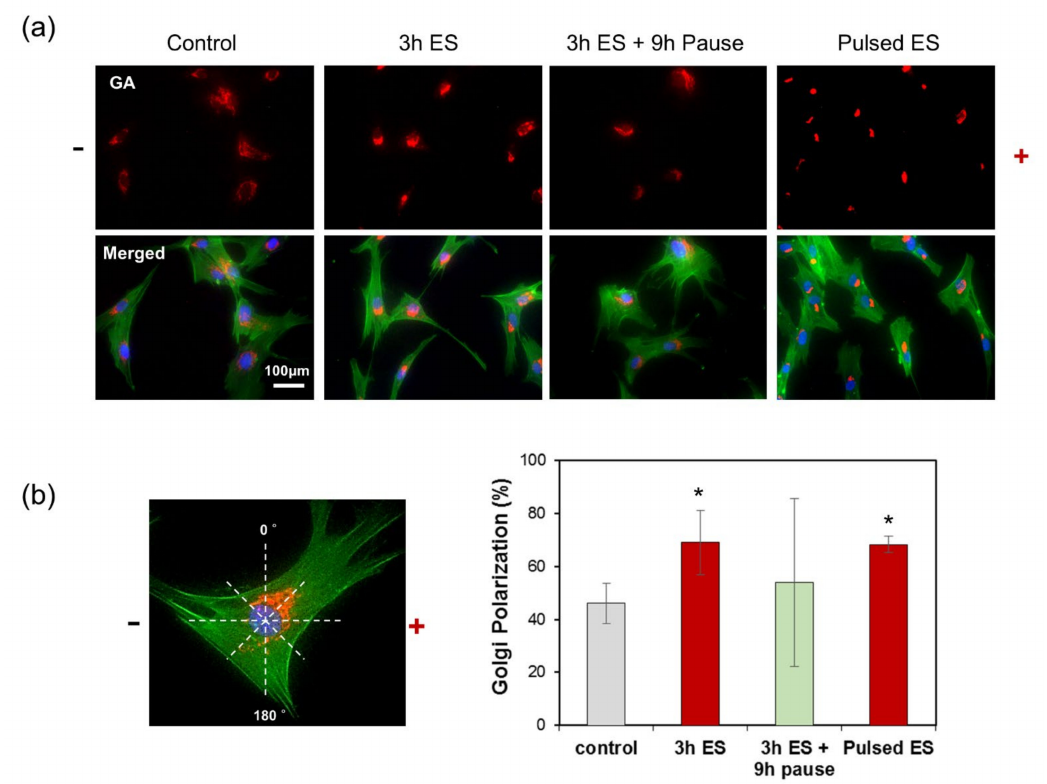
Figure 5. Golgi polarization of ADSCs under electrical stimulation. ( a ) Immunostaining of the actin cytoskeleton, nucleus, and Golgi apparatus of cells exposed and not exposed to electric signaling. Cells were fixed and triple-labelled with GM130 antibody (Golgi marker, red), Alexa Fluor 488-conjugated phalloidin (F-actin, green), and Hoechst #33258 (nucleus, blue). ( b ) The percentage of cells presenting with Golgi polarization towards the anode, counted in the 0–180 ◦ range. * represents p < 0.05 compared to controls not exposed to electric